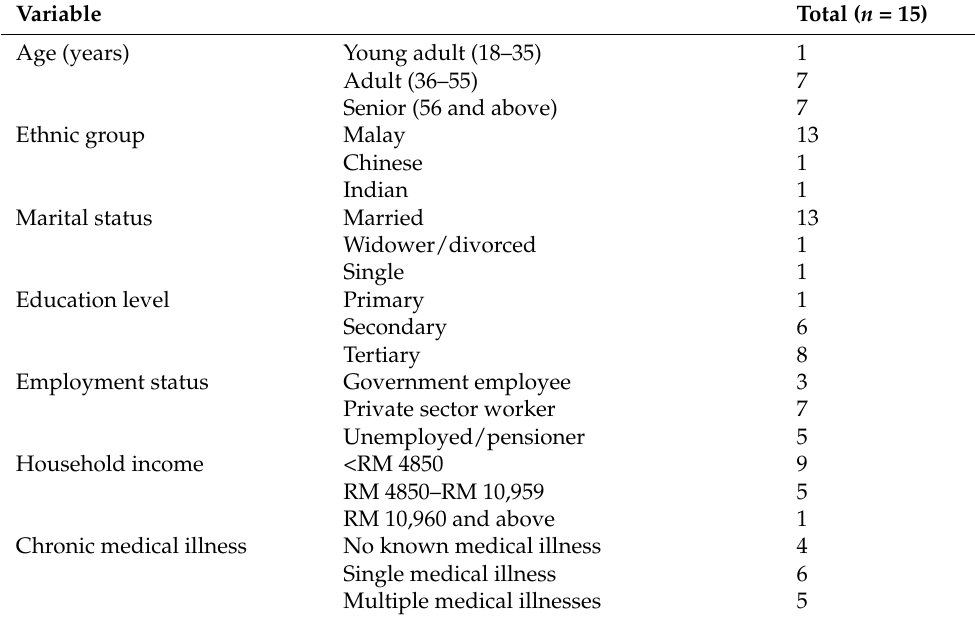
Table 2. Characteristics of the participants ( n = 15).